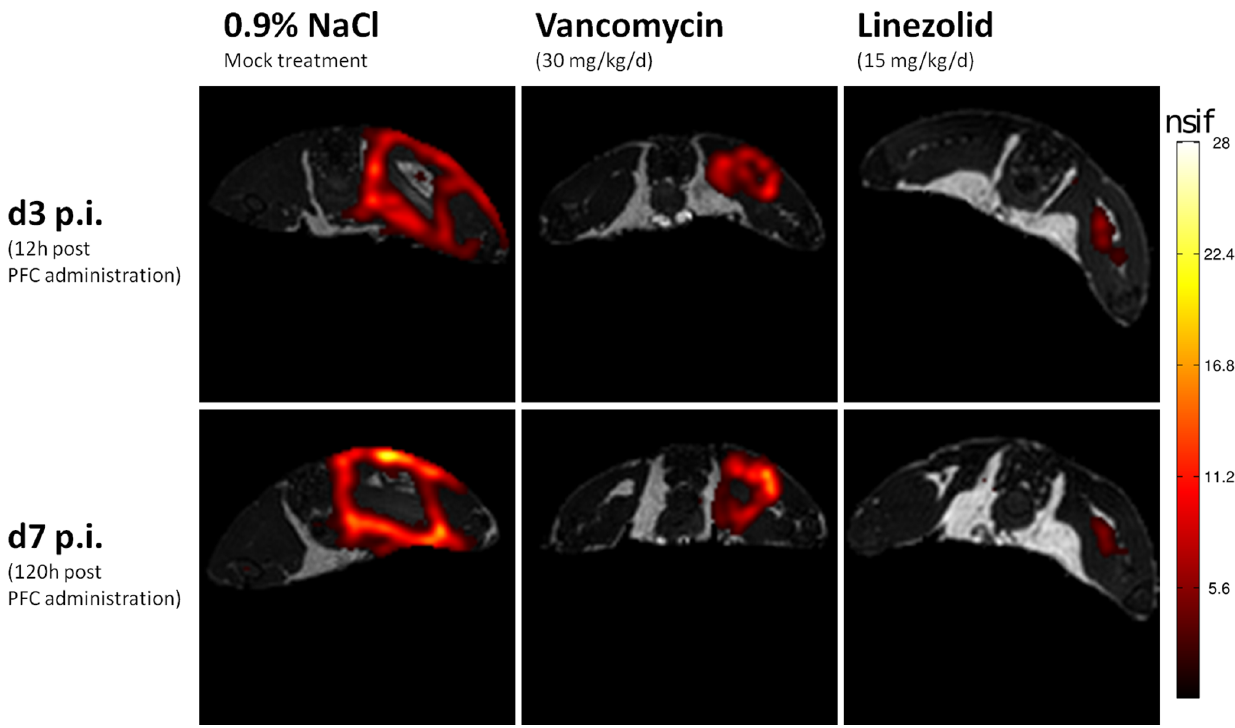
Figure 2. Representative 19F chemical shift imaging steady-state free precession overlays on 1H-turbo spin echo scans of one mouse from each group during infection and antibiotic therapy. S. aureus Xen 29 (3.2 6 10 8 ) was injected into the left thigh muscle and the PFC tracer was administered intravenously 48 h post-infection. Each mouse underwent magnetic resonance imaging at 12 h and 120 h after PFC administration. All groups showed strong accumulation of 19 F at the rim of the abscess area. The 19 F signal intensity is indicated by the hot (red to white) color scale superimposed over a grey 1 H image, which shows the anatomical context.